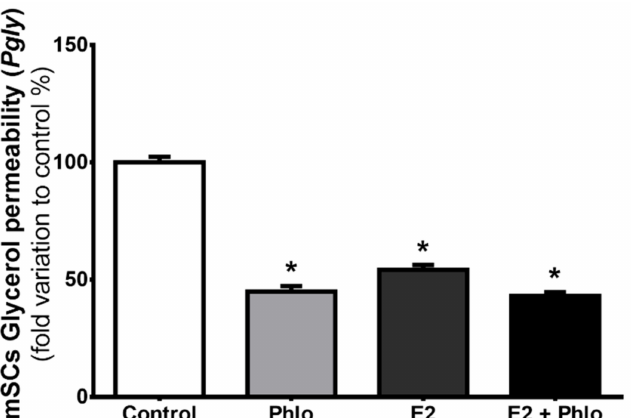
Figure 4. Effects of 0.7 mM phloretin, 17 β -estradiol (E2) 100 nM and E2 with exposure to phloretin in mouse Sertoli cells permeability to glycerol ( P gly ). Results are expressed as mean ± SEM ( n = 6). * p < 0.05 relative to